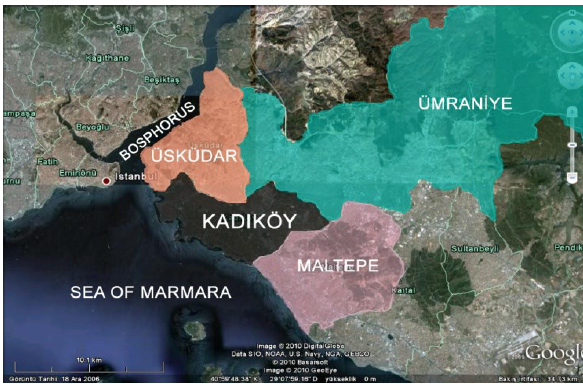
Figure 1. Kadıköy’s Location within Istanbul (Developed by Author).